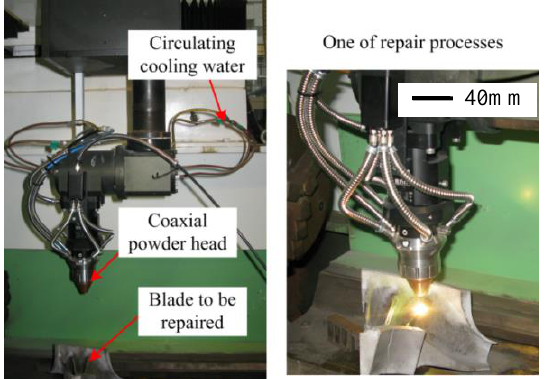
Figure 5. LAM process. Figure 5. LAM